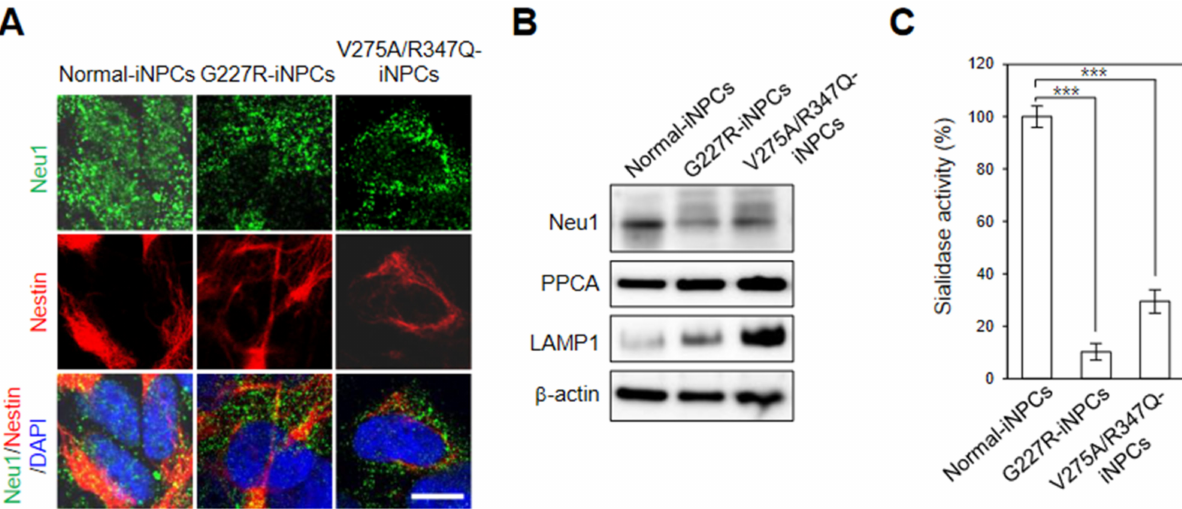
Figure 3. Disease-specific phenotypes of sialidosis-iNPCs. ( A ) Representative immunohistochemistry images of normal- and sialidosis-iNPCs (G227R- and V275A/R347Q-iNPCs) stained for NEU1 and the NPC marker Nestin. Nuclei were counterstained with DAPI (blue). (Scale bar = 10 µ m) ( B ) Western blot analysis of NEU1, PPCA, and LAMP1 expression in normal- and sialidosis-iNPCs. β -actin was used as the loading control. ( C ) Sialidase activity of normal- and sialidosis-iNPCs. The data are the means ± SDs of at least 3 independent experiments. *** p < 0.001, compared to control normal-iNPCs ( t